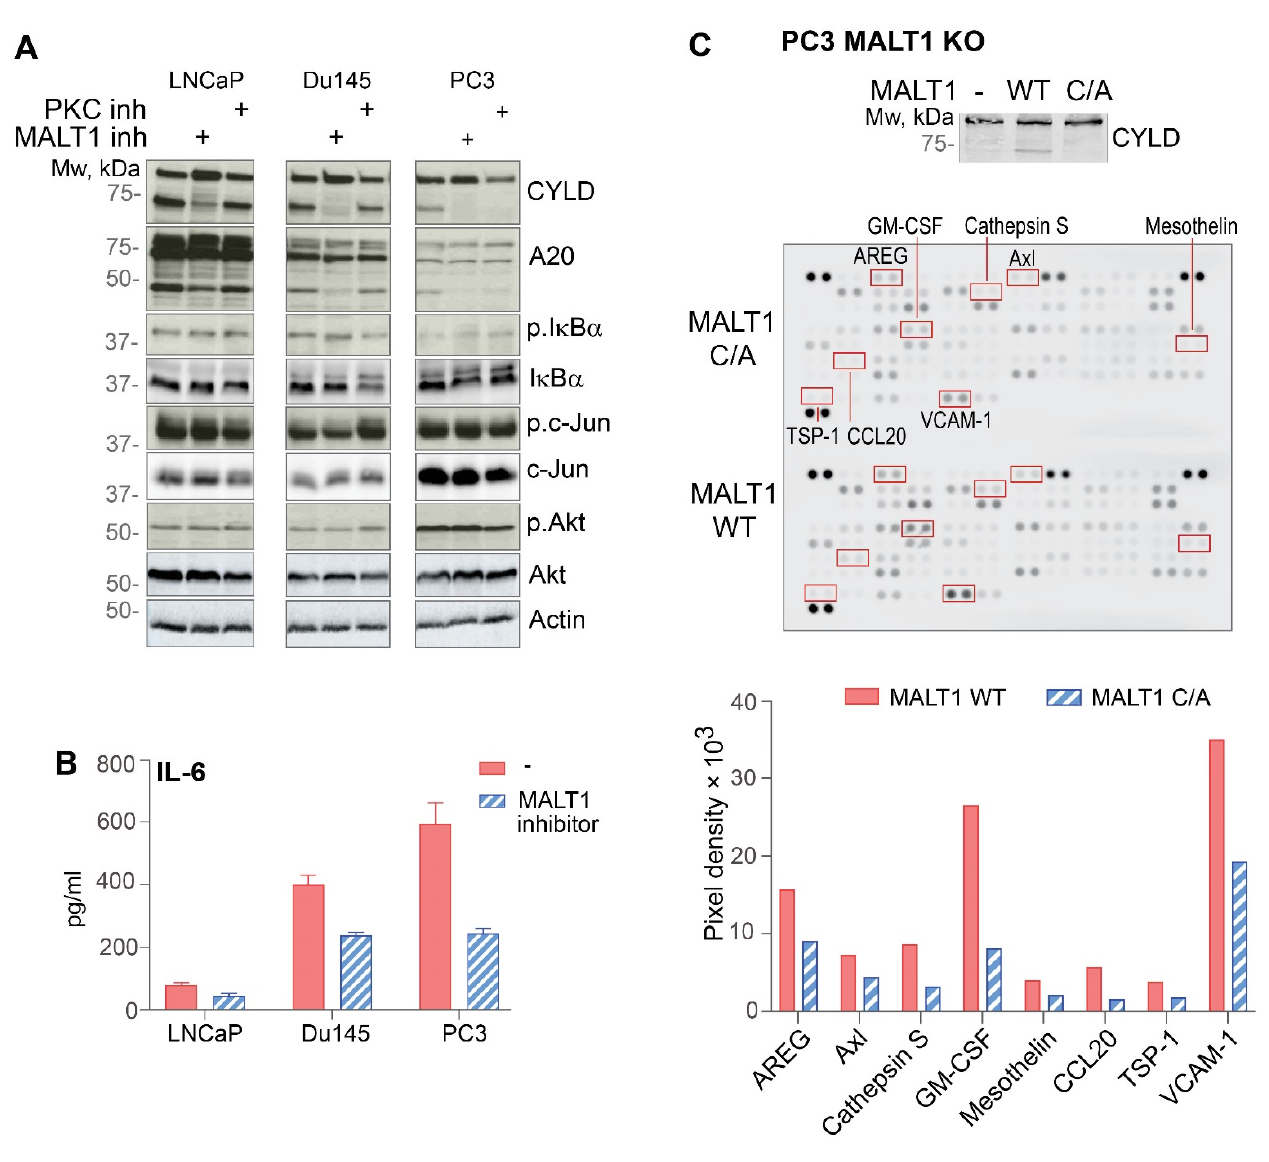
Figure 5. MALT1 proteolytic activity is not essential for constitutive NF- κ B, JNK and Akt signalling in PCa cells, but contributes to the expression of cancer-related proteins. ( A ) PCa cell lines were treated with MALT1 (1 µ M) or PKC inhibitor (10 µ M) for 48 h (+ indicates each type of inhibitors applied to each cell line). CYLD and A20 processing, as well as c-Jun, I κ B α , and Akt phosphorylation, were analysed by immunoblotting using the corresponding phospho-specific antibodies. ( B ) PCa cell lines were pre-treated with MALT1 inhibitor (2 µM) for 48 h, after which the media were refreshed with fresh inhibitor and analyzed for IL-6 expression in the supernatant by ELISA after additional 48 h. ( C ) PC3 MALT1 KO cells were reconstituted with either wild type MALT1 (WT) or catalytically inactive MALT1 (C/A), as indicated. CYLD cleavage was visualised by western blot of the corresponding cell extracts. Cells were treated with Brefeldin A. After 6 h, expression of 84 human cancer-related proteins was analyzed via a multiplex antibody array. Quantification was conducted using ImageJ 1.53 software [45] and is shown in the bottom panel for a selected number of proteins (marked with red boxes). Results ( A , B ) are representative of three independent experiments. Error bars ( B ) represent means ± SEs.